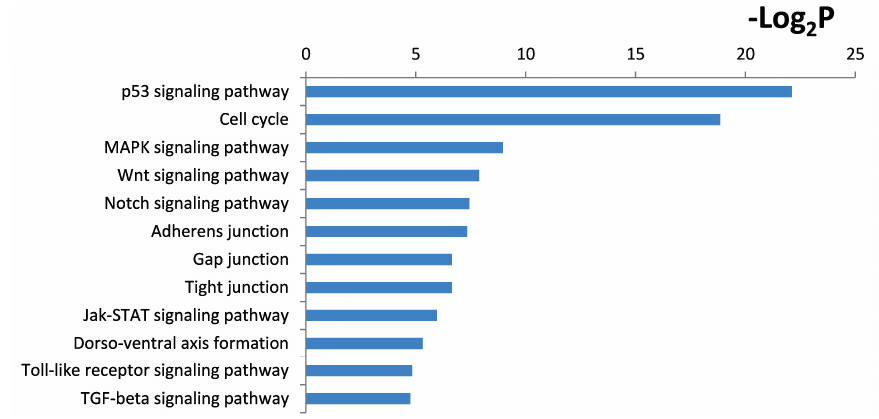
Figure 5. Kyoto encyclopedia of genes and genomes (KEGG) pathway analysis within the target genes of significantly altered miRNAs after PQ exposure was performed using DAVID bioinformatics tools. The enriched KEGG pathways were identified and listed according to their enrichment p -value ( p <